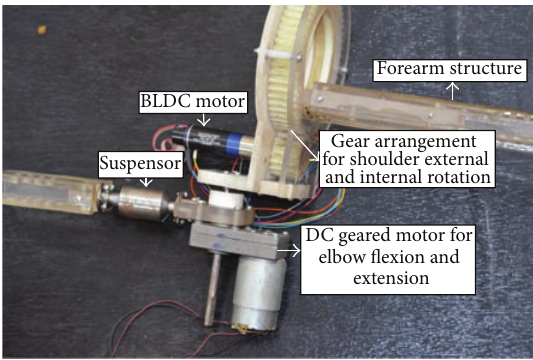
Figure 8: Manufactured model of elbow joint.